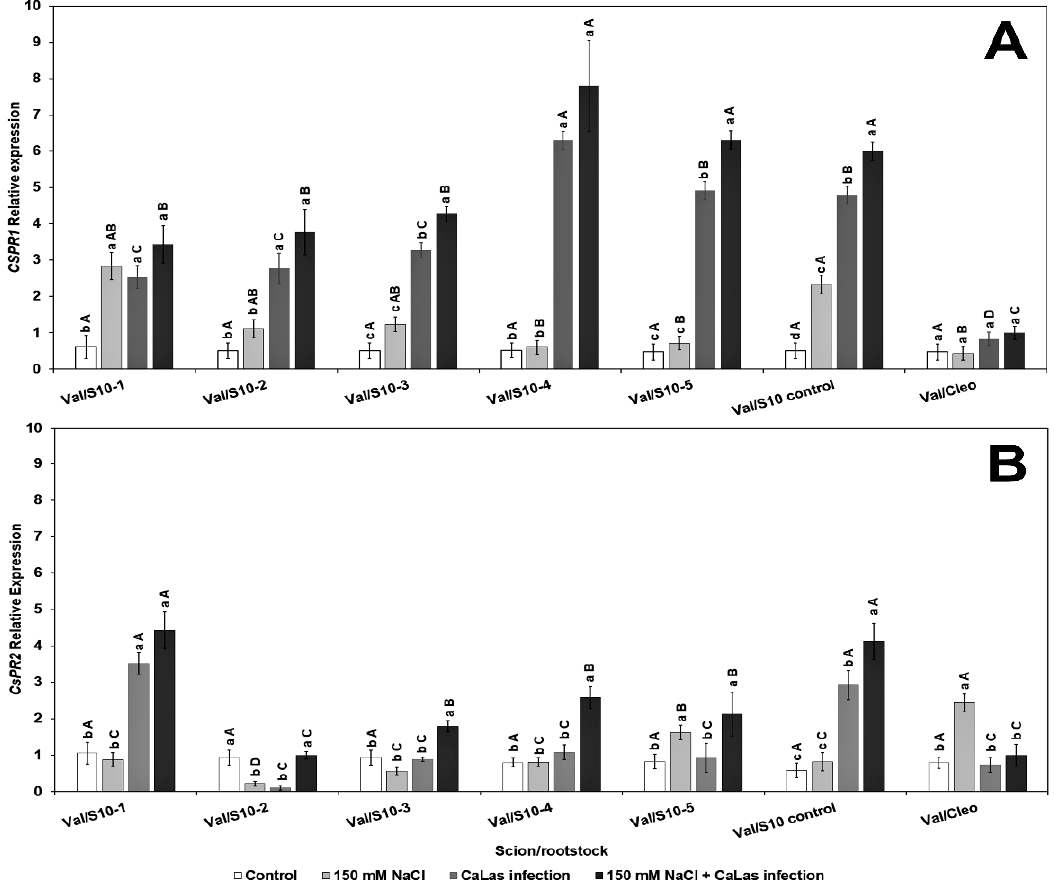
Figure 3. Effect of NaCl stress and Ca Las infection expression of defense-related genes in ‘Valencia’ sweet orange scions grafted onto S10-derived rootstocks or Cleopatra mandarin (control). ( A ), CsPR1 and ( B ). CsPR2 . Mean separation between rootstocks at a particular treatment is indicated by differing uppercase letters; mean separation between treatments in a particular rootstock is indicated by differing lowercase letters by Tukey’s honestly significant difference test ( p ≤ 0.05).